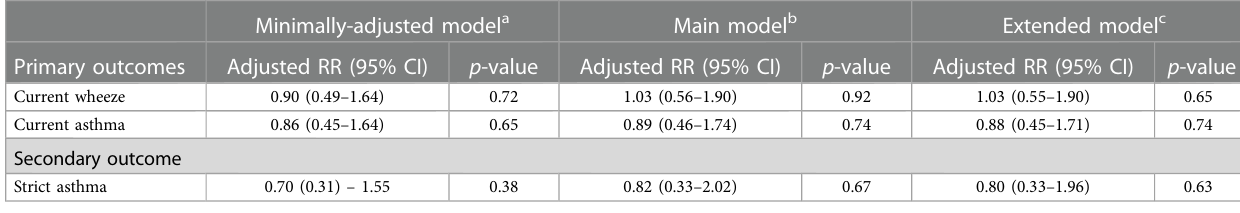
TABLE 4 Association between maternal occupation exposure to cleaning chemicals during pregnancy and airway